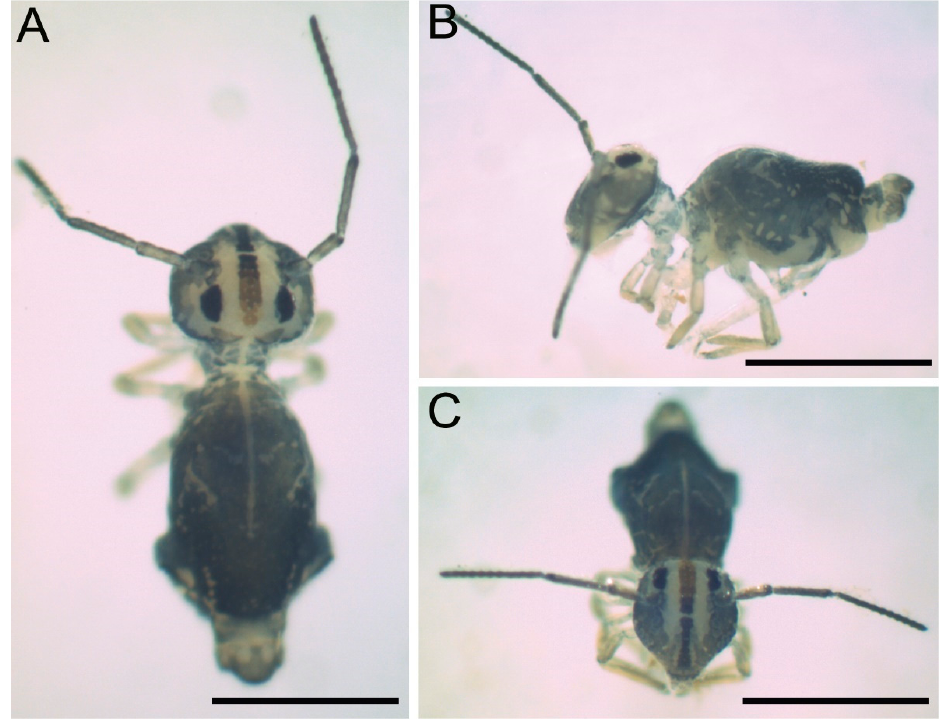
Figure 4. Habitus of Arlesminthurus caatinguensis sp. nov. fixed in ethanol, female: ( A ) dorsal view; ( B ) lateral view; ( C ) frontal view. Scale bars: 0.5 mm.